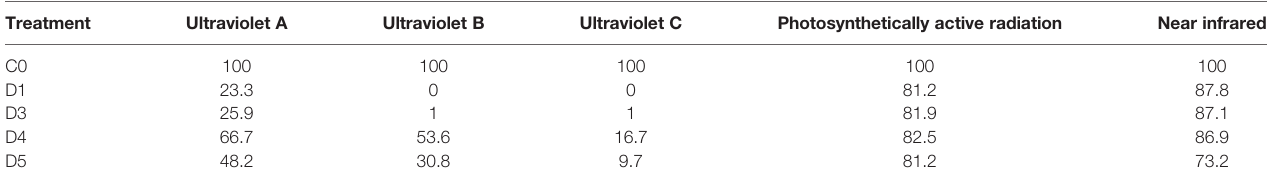
TABLE 1 | Percent of solar radiation transmitted through the overhead shade fi lms.